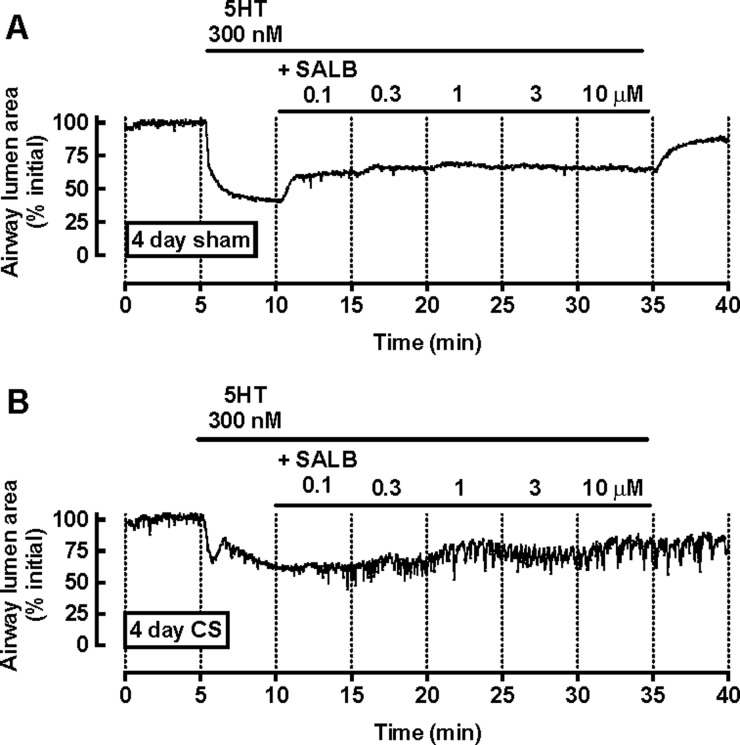
SALB-mediated relaxation is decreased following CS exposureMice were exposed to room air (sham) or CS for 4 days before preparation of PCLS. Representative traces from (A) sham- and (B) CS-exposed mice show a frame-by-frame analysis (0.5 Hz) of changes in airway lumen area with time in the presence of 300 nM 5HT and increasing concentrations of SALB.